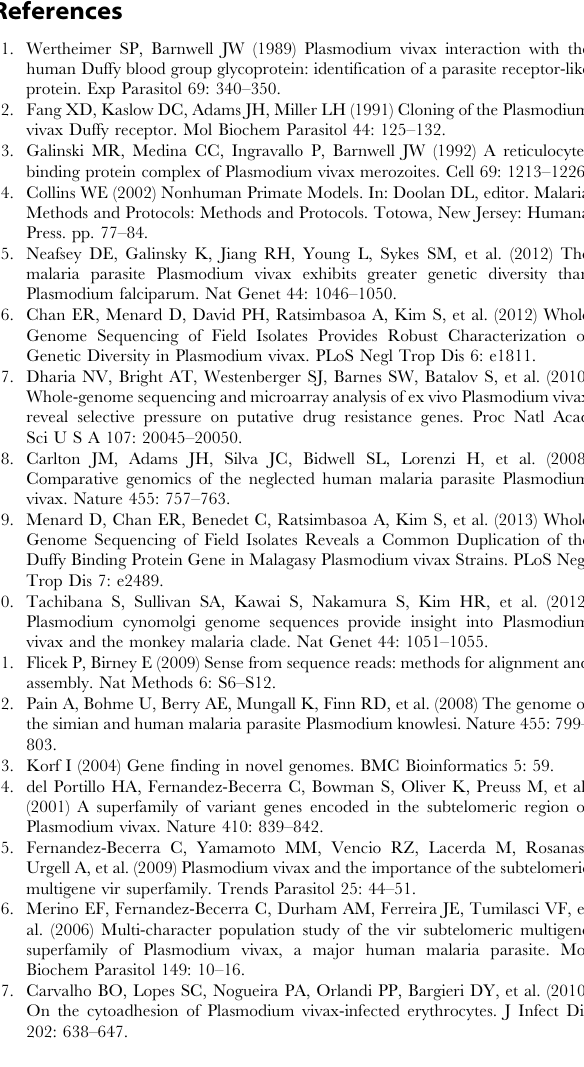
Figure S7 DNA sequence identity (y-axis, in %) between the C127 contig carrying the predicted EBP gene (indicated by the red box) and its orthologous P. cynomolgi contig (x-axis, in bp). Figure S8 Amino acid alignment of the C-terminus cysteine-rich like domain for DBP genes and the novel P. vivax and P. cynomolgi EBP genes. The grey boxes indicate conserved cysteine positions. Figure S9 Phylogenetic tree showing the relationships between the amino-acid sequences of P. vivax samples for several RBP2 genes and the putative RBP2e.